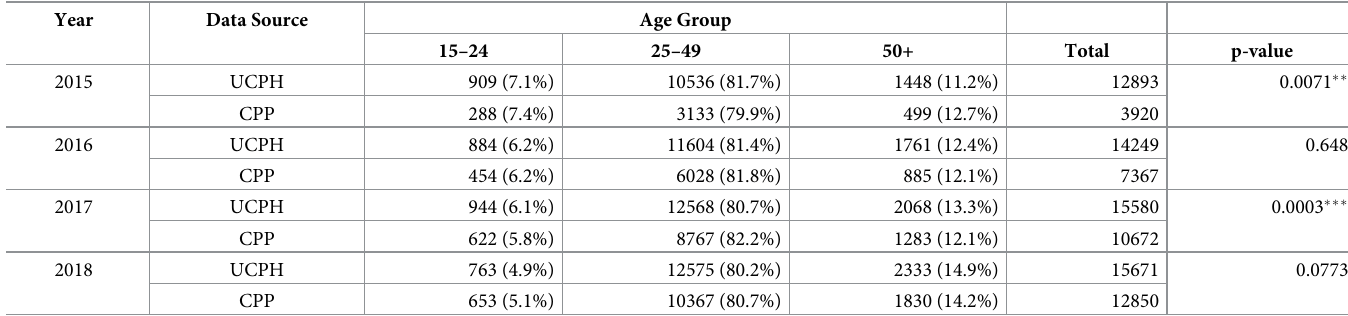
Table 4. Comparison of UCPH and CPP data by year and age group.